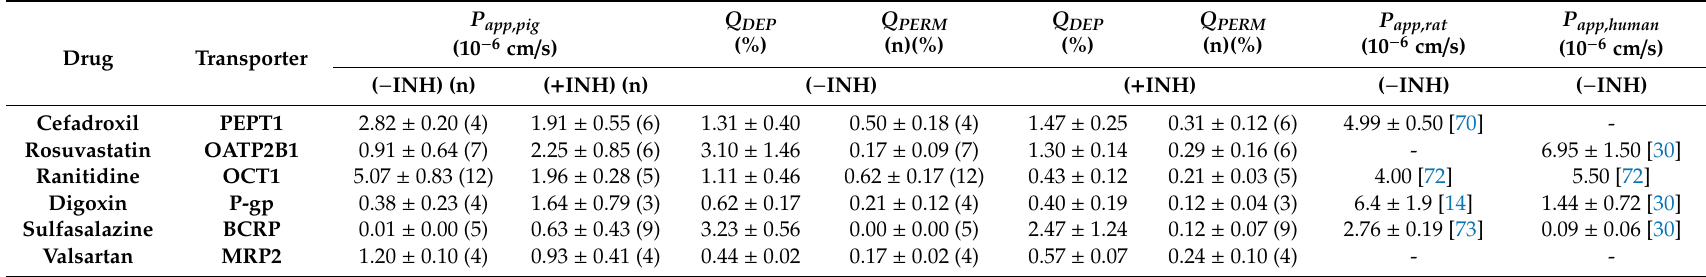
Table 2. P app,pig , Q DEP and Q PERM of the tested transporter substrates in the absence and presence of the inhibitor, using ex vivo porcine jejunum and comparison with P app,rat / P app.human data from the